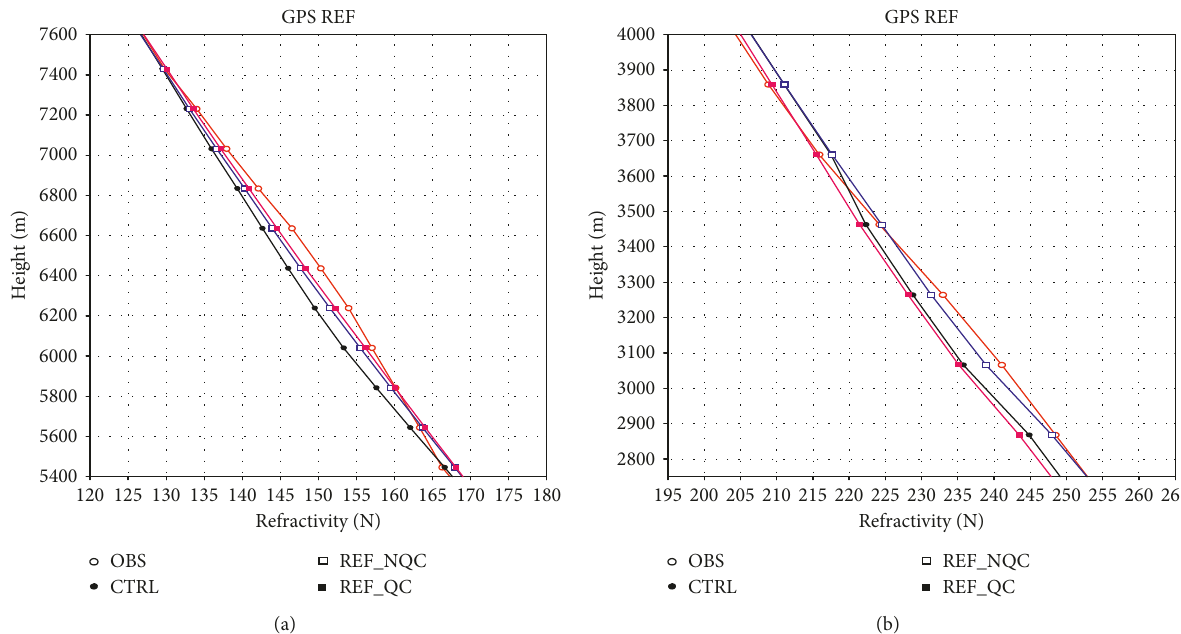
Figure 2: Comparison of different initial values and occultation refractivity observations in the middle-upper troposphere (a) and middle- lower troposphere (b) represents actual occultation observations (OBS), • stands for the reference control test (CTRL), nonquality control scheme (REF_NQC), and represents the quality control scheme ○ ■